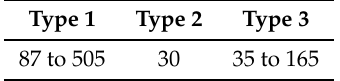
Table 2. Numbers of the extracted feature points.